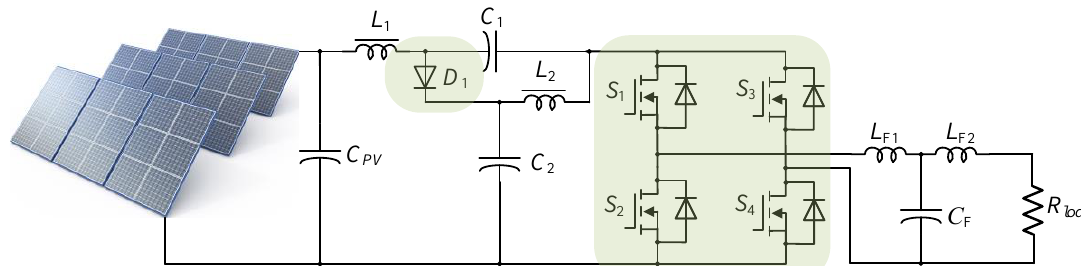
Figure 2. The 2L QZS inverter.